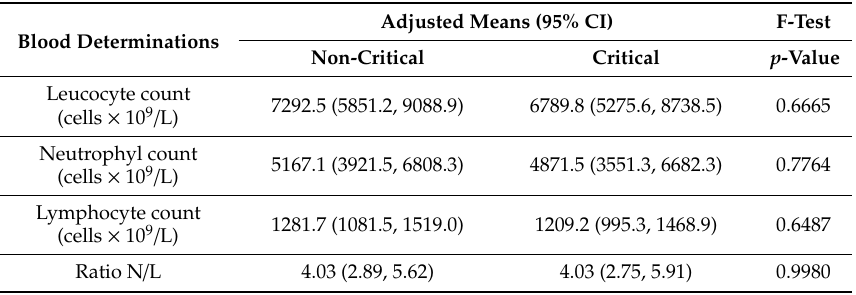
Table 2. Association of blood determinations with COVID-19 evolution after statistical control by age, gender, and time from symptoms